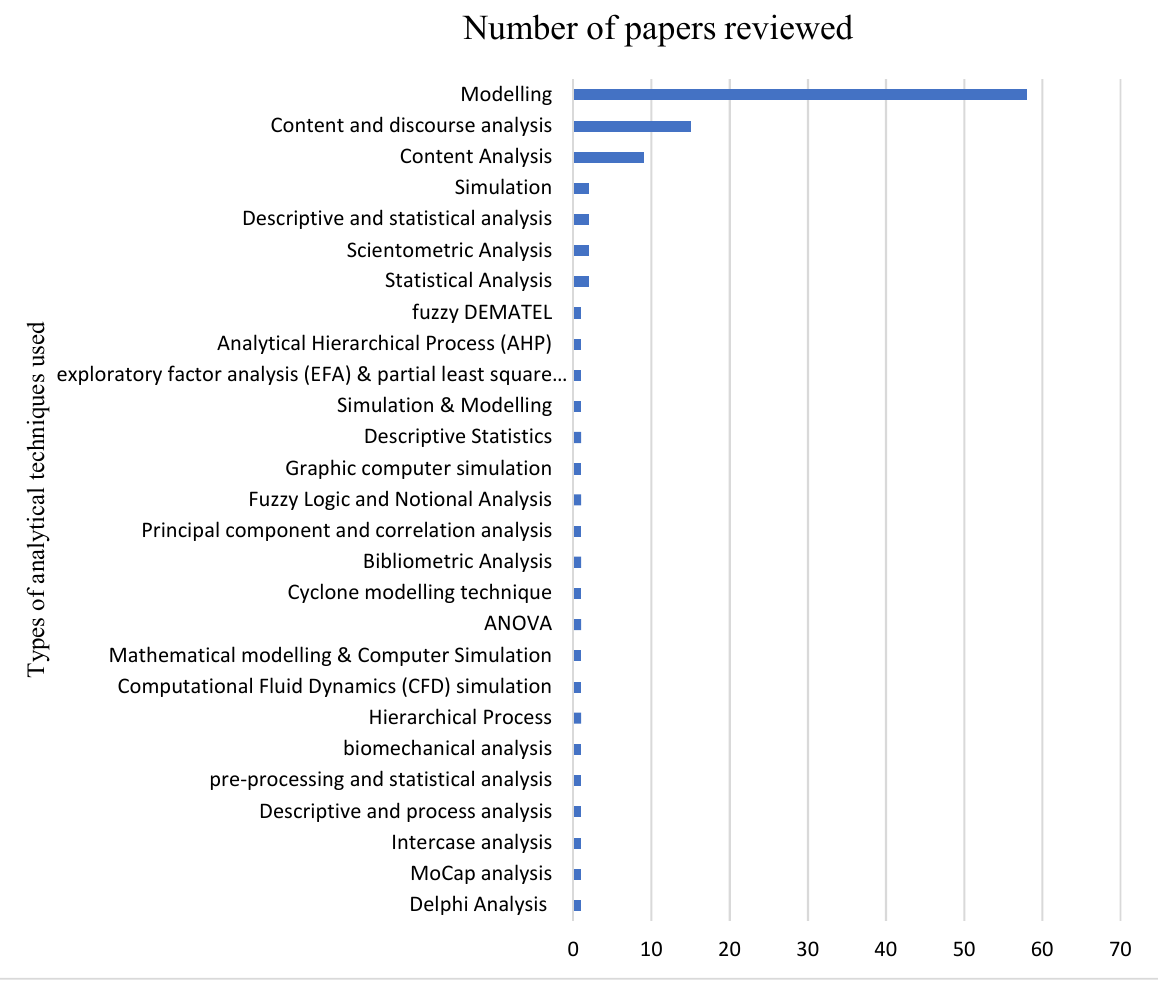
Figure 9. Analytical techniques used in the construction robotics and human–robot teams literature.